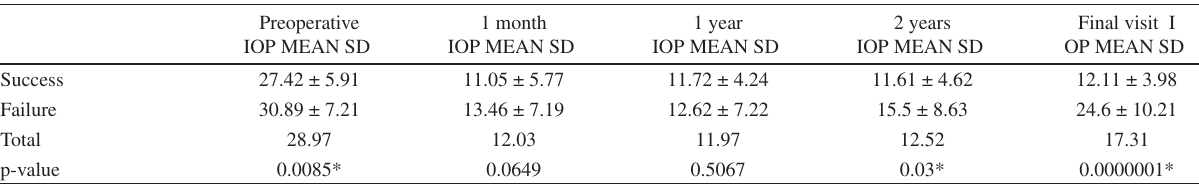
Table 1 - Iintraocular pressure (IOP) follow-up